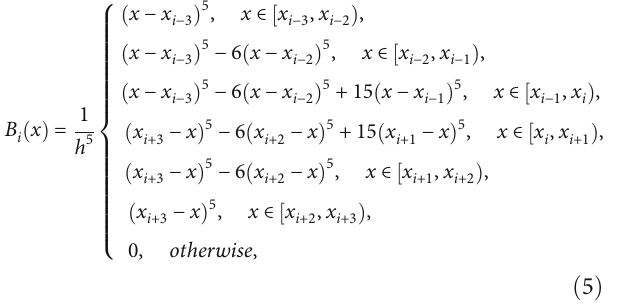
the region a ≤ x ≤ b . Each quintic B-spline covers six ele- ments, so that a total of six quintic B-splines cover one ele- ment. Table 1 summarizes the values of B four derivatives.